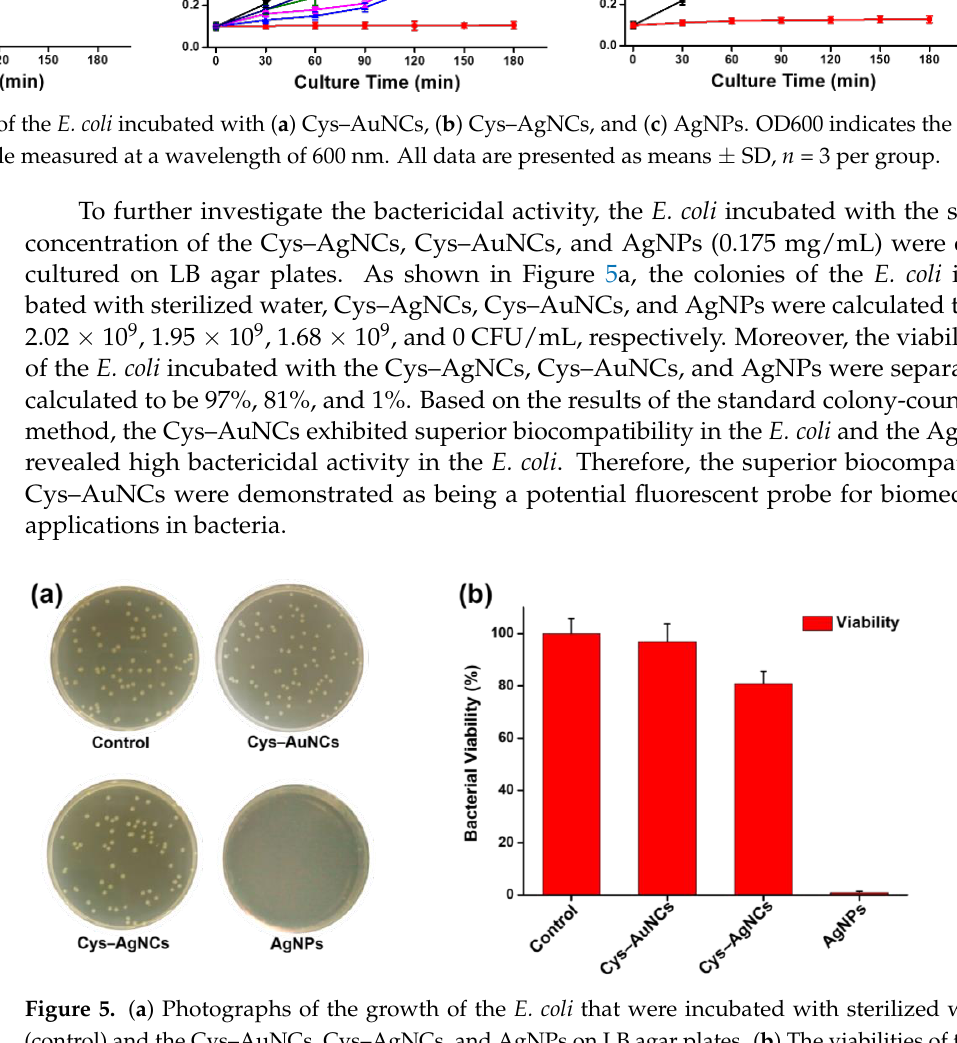
Figure 5. ( a ) Photographs of the growth of the E. coli that were incubated with sterilized water (control) and the Cys–AuNCs, Cys–AgNCs, and AgNPs on LB agar plates. ( b ) The viabilities of the E. coli that were separately incubated with sterilized water (control) and the Cys–AuNCs, Cys– AgNCs, and AgNPs. In the control experiment, the viability of the E. coli incubated with sterilized water was set to 100%. All data are presented as means ± SD, n = 3 per group.